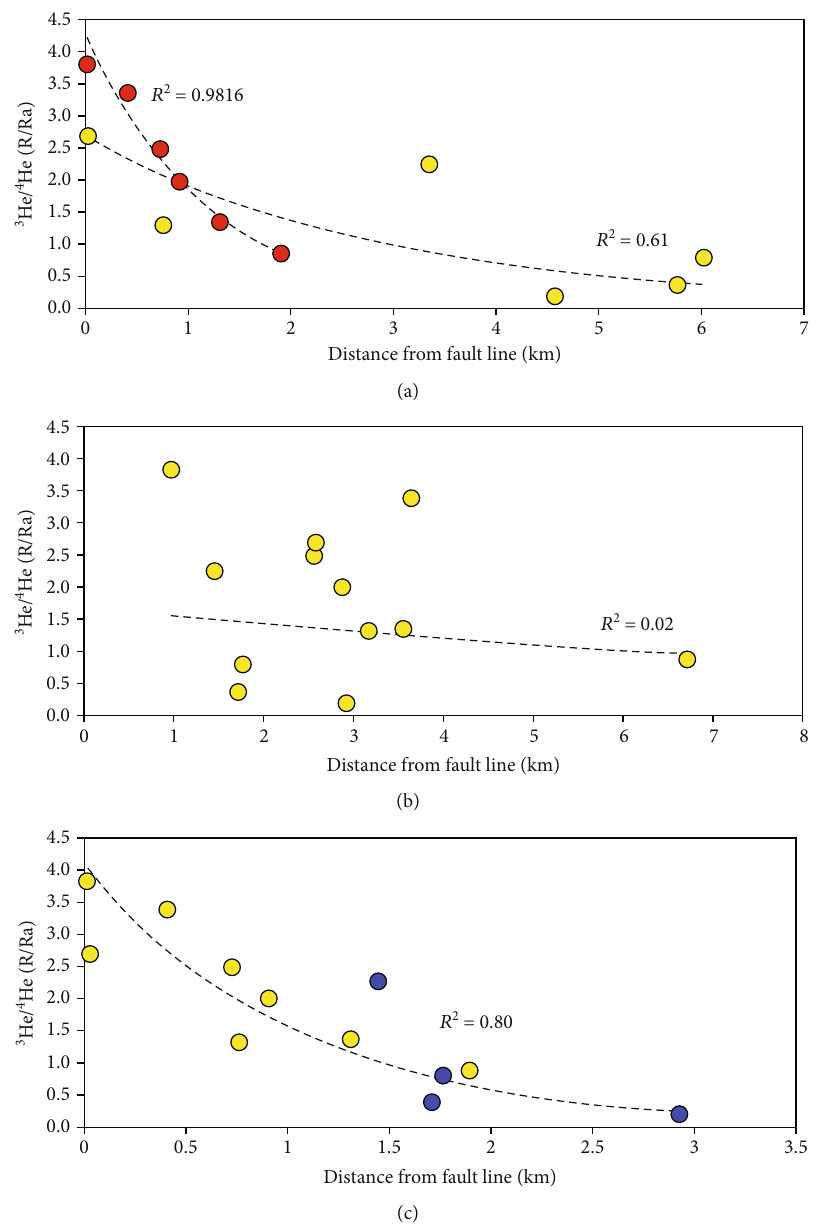
Figure 5: (a) 3 He/ 4 He ratios to distance from the Heunghae fault line. Samples at latitudes higher than P-12 are marked with red circles. (b) 3 He/ 4 He ratios to distance from the Namsong fault line, which is not prominent. (c) 3 He/ 4 He ratios to distance from closer fault lines between the Heunghae and Namsong fault lines. Samples closer to the Namsong fault than the Heunghae fault are marked with blue